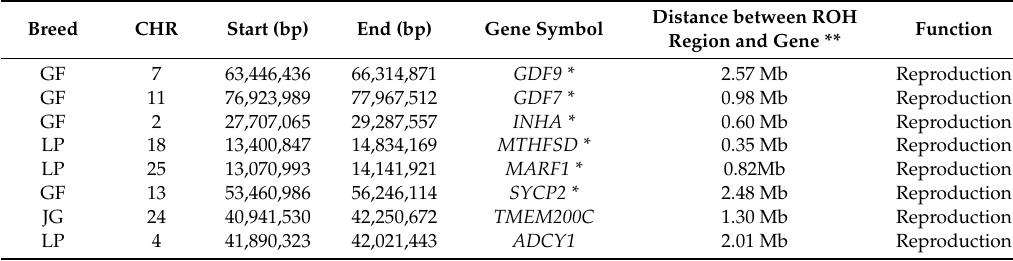
Table 6. List of candidate genes located in genomic regions with a high frequency of ROHs associated with goat reproductive